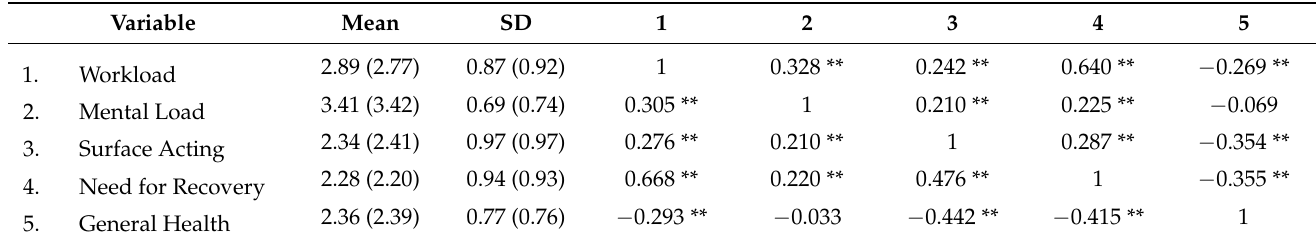
Table 1. Means, standard deviations, and correlations among study variables (back-office sample N = 436; front-office sample N = 734).